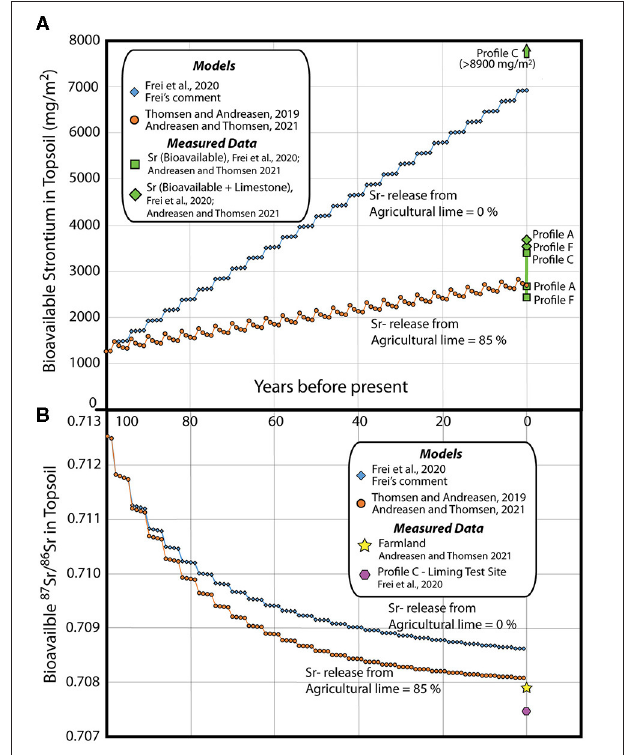
FIGURE 1 | Calculation of Sr content (A) and Sr isotopic composition (B) in the topsoil of a hypothetical soil profile where modern farming commenced 100 years ago, using the model presented by Frei et al. (2020) and Frei (2021) (blue diamonds) with complete Sr retention and the model with very limited retention presented by Thomsen and Andreasen (2019) and Andreasen and Thomsen (2021) (orange circles). Agricultural lime (2 t/ha) is added every 4 years, manure and fertilizer every year, removal of Sr through crop yield is yearly. For the sake of simplicity and modeling general behavior, soil use remains constant over the entire period. The starting value of 1,250 mg/m 2 is based on unlimited heathland samples in the area of the sites studied in Andreasen and Thomsen (2021), as is the starting 87 Sr/ 86 Sr ratio. Parameters for farming are from Thomsen and Andreasen (2019). Measured levels of bioavailable strontium (ammonium nitrate extract) in the topsoil are shown in (A) as green squares and bioavailable + limestone (ammonium nitrate + acetic acid extracts) as green diamonds [ Frei et al., 2020 (Liming Test Site, Profile C); Andreasen and Thomsen, 2021 (Farmland, Profiles A and F)]. Measured strontium isotopic values for farmland (Andreasen and Thomsen, 2021) and Profile C, the liming test site (Frei et al., 2020) are shown as a yellow star and purple hexagon, respectively in (B)